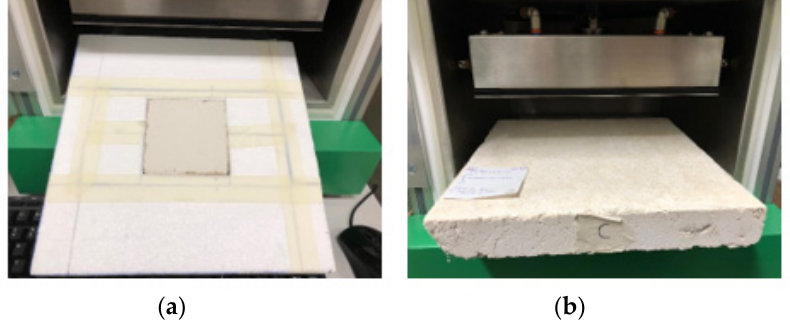
Figure 4. Example of the application of the expanded polystyrene (EPS) to a sample (S05) with 100 × 100 mm 2 dimensions ( a ), and example of a sample (S10) with a surface equal to 300 × 300 mm 2 ( b ).